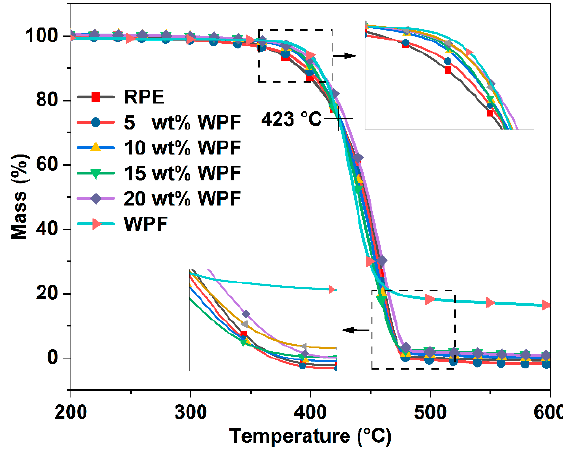
Figure 4. TG curves of RPE, WPF and RPE/WPF composites with different WPF contents.